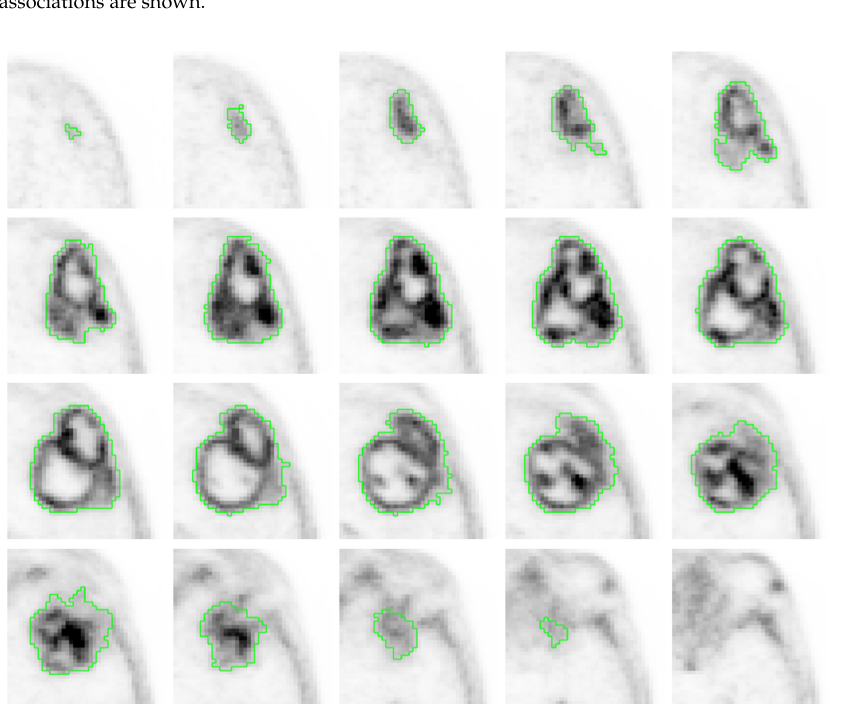
Figure 6. Bubble chain morphology and low sphericity (0.56) in the three-dimensional representa- tion of the segmented tumor of patient 2 (see Figure 5).